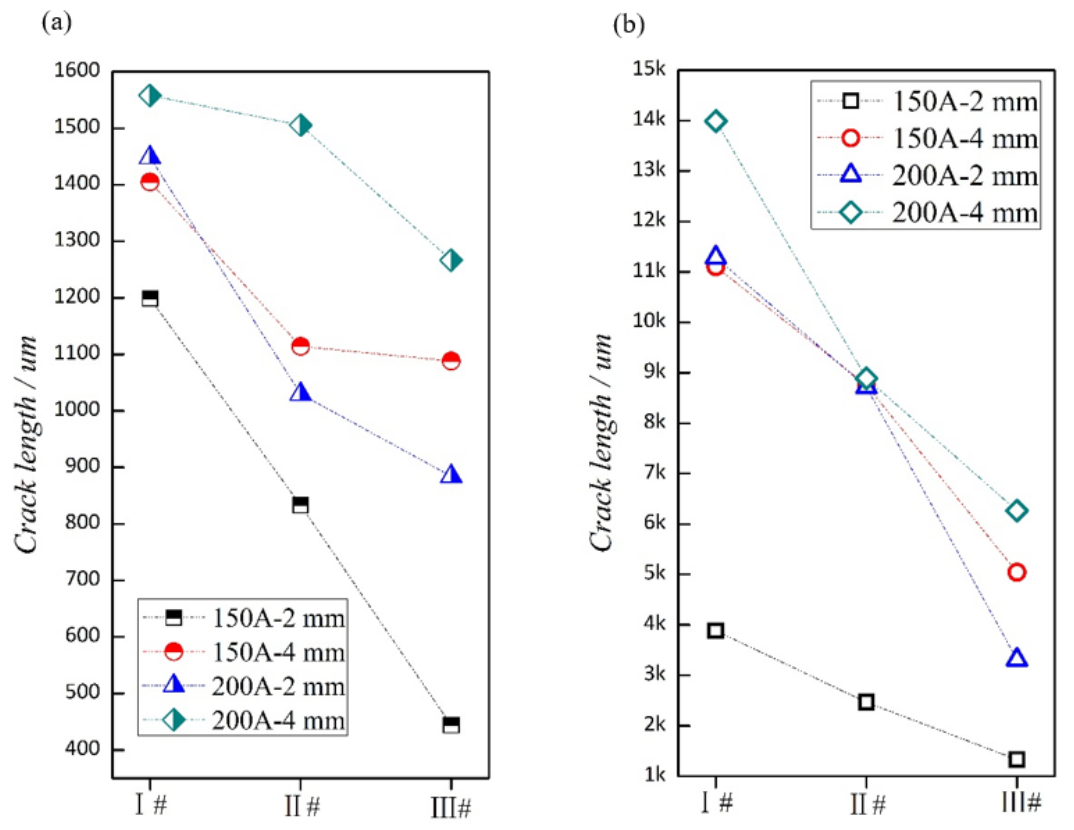
Figure 4. SFC crack statistics: ( a ) the maximum crack length and ( b ) the total length of the crack.